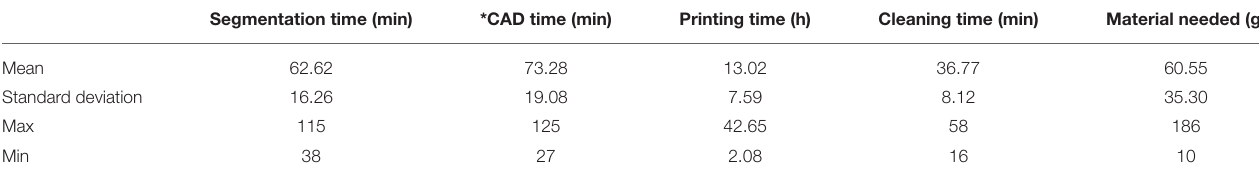
TABLE 2 | Summary of the heart model fabrication data.